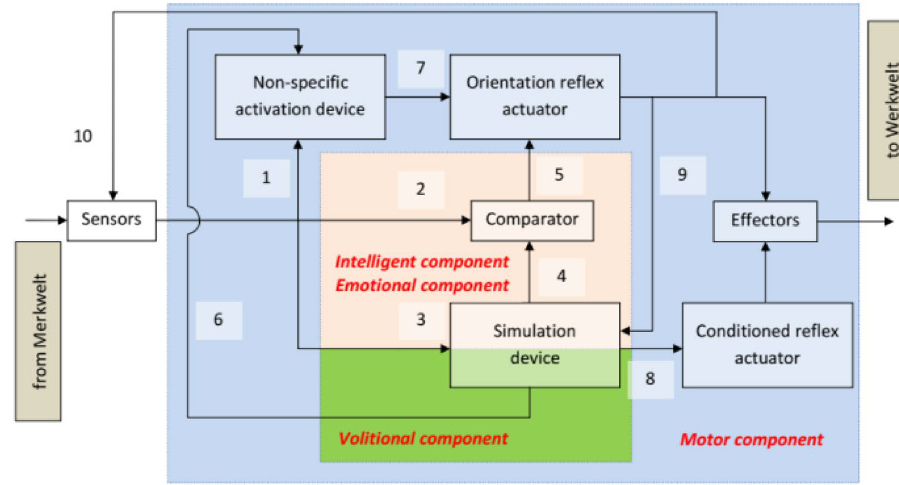
Fig. 2 Interaction of core components during stimulus